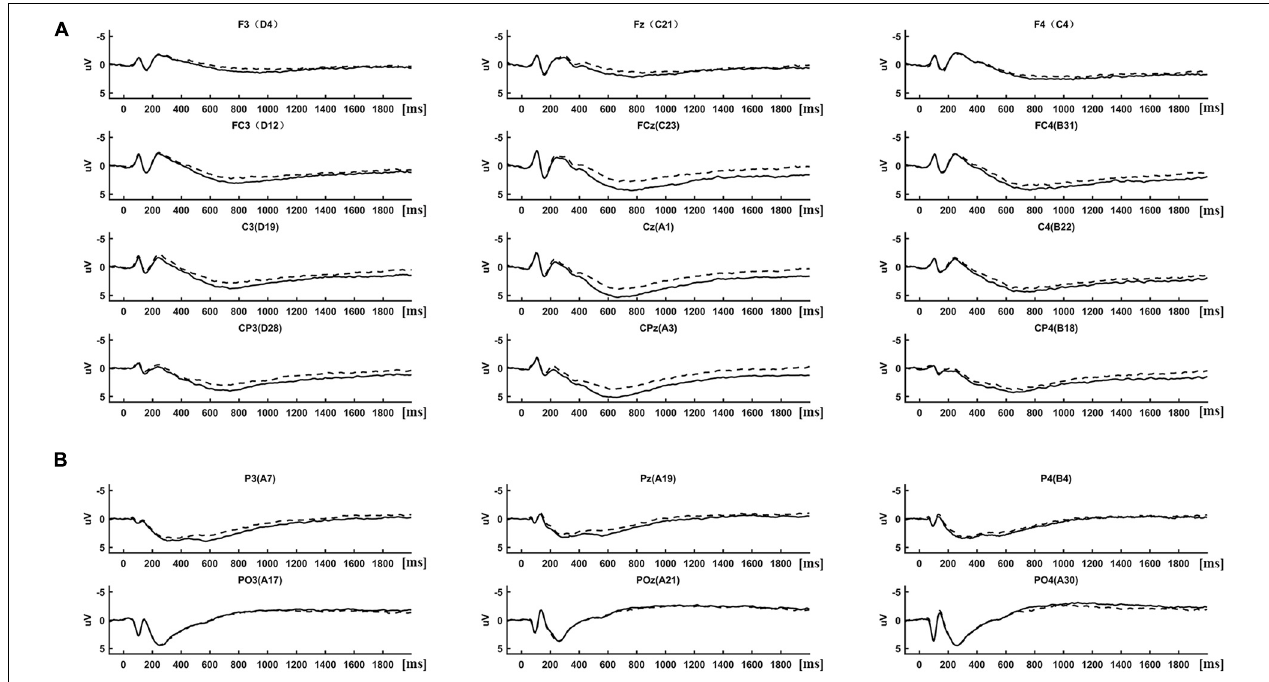
FIGURE 2 | ERP differences between IRA engendered and IRA un-engendered condition, both at the LPP (A) and the P300 (B) .